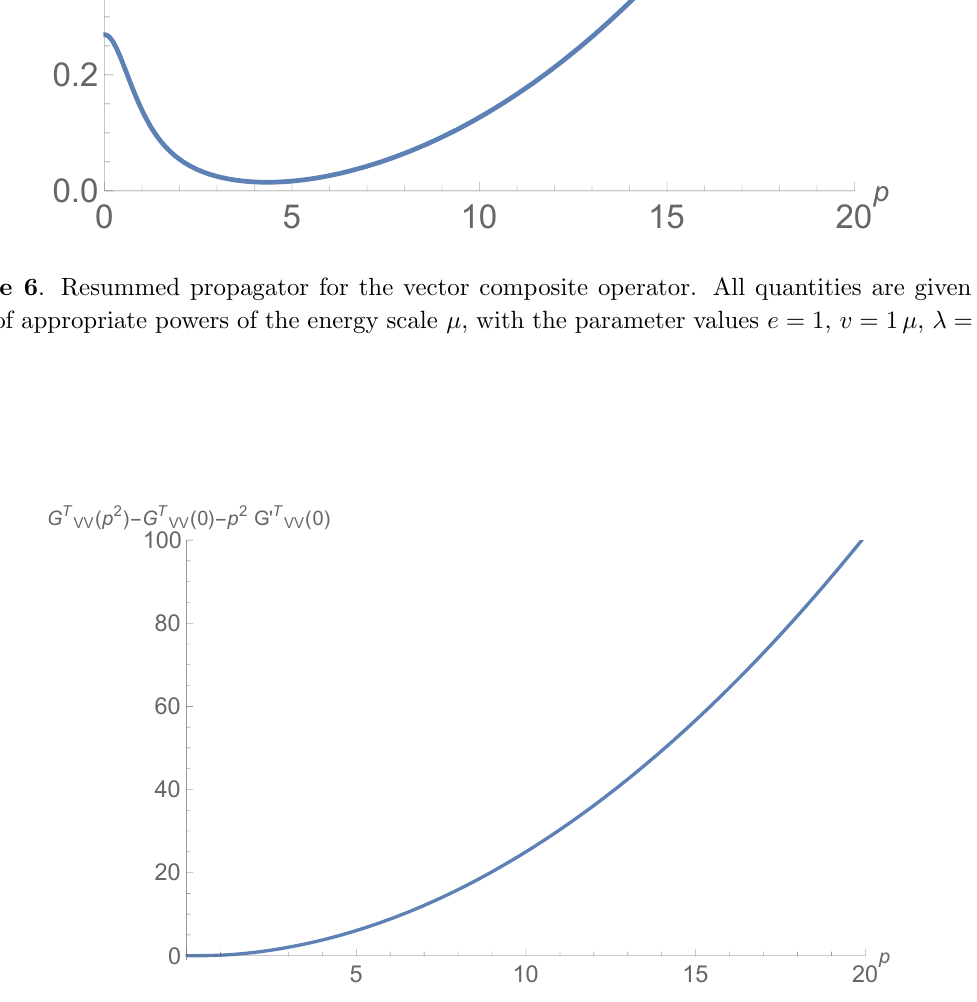
Figure 7 . Resummed propagator with a double subtraction for the vector composite operator. All quantities are given in units of appropriate powers of the energy scale (cid:22) , with the parameter values e = 1, v = 1 (cid:22) , (cid:21) = 1 5